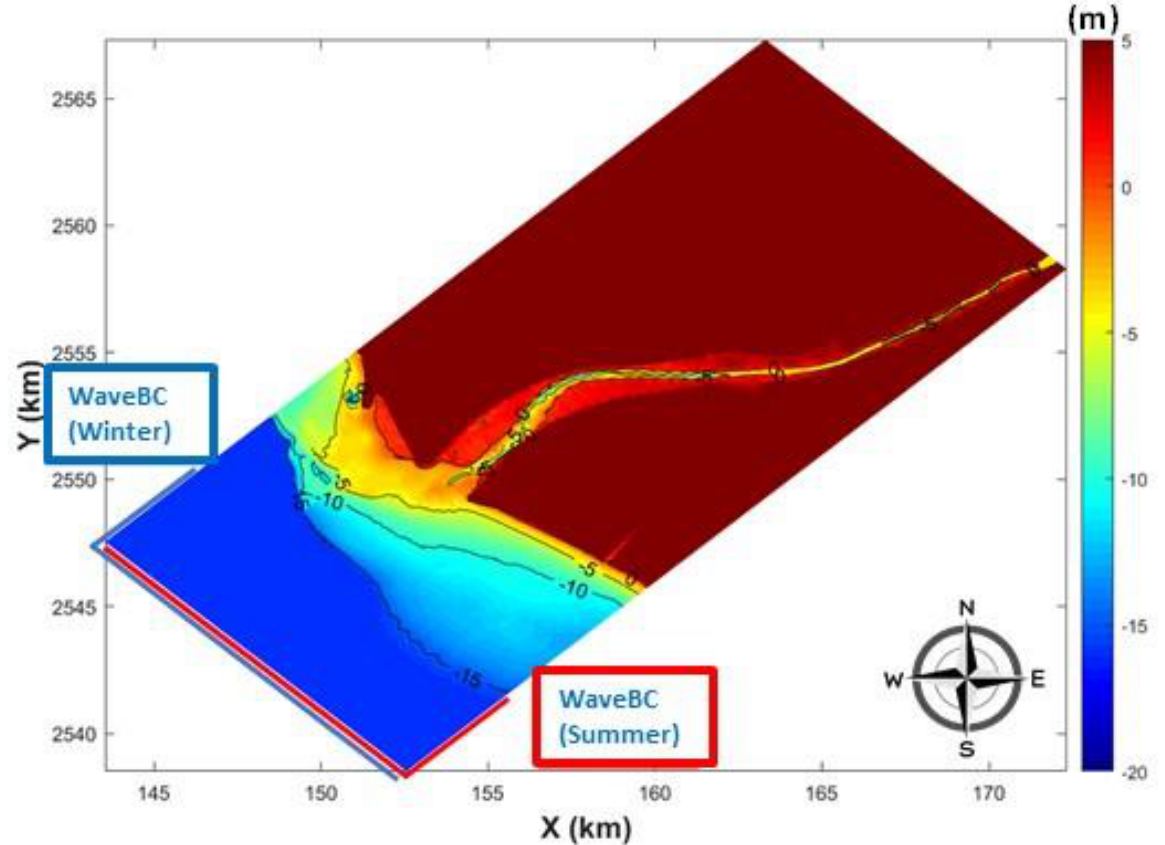
Figure 4. The computational domain (color contours: depth, scale on the right). The tidal constituents provided by the global tidal level forecast of Oregon State University (OSU) are applied at the open boundaries of the circulation model SHORECIRC. The significant wave height and peak period observed at the Anping station are applied to the boundary of the spectral wave model SWAN. The direction of observed waves is from the northwest during winter and from the south to the southwest during summer.